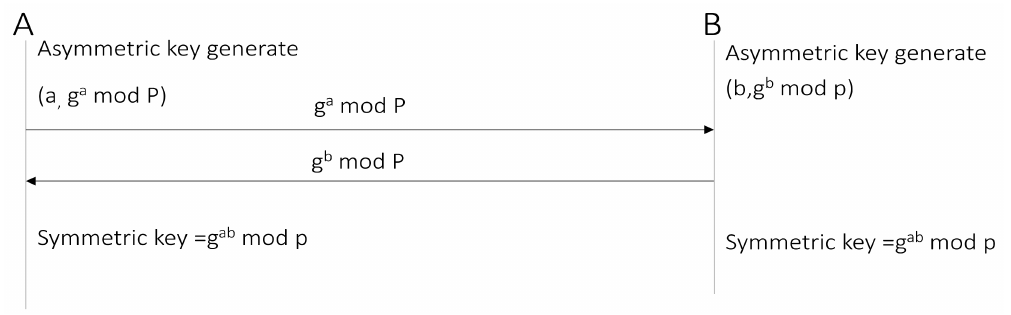
Figure 2. Di ffi e–Hellman’s key generation